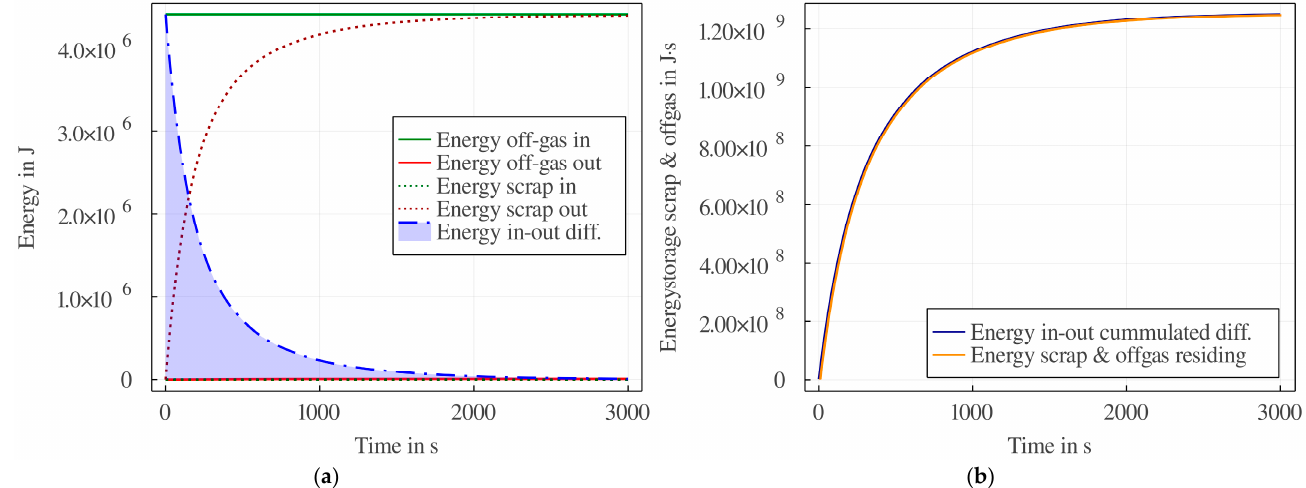
Figure 17. Energy in-, outputs and difference over time ( a ); cumulated energy difference and energy stored inside the bulk (scrap and off-gas) ( b ).